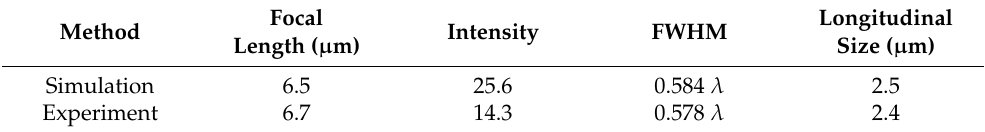
Table 2. Photonic jet-like beam formation via illumination on 10 µ m silica microcylinder in free space.